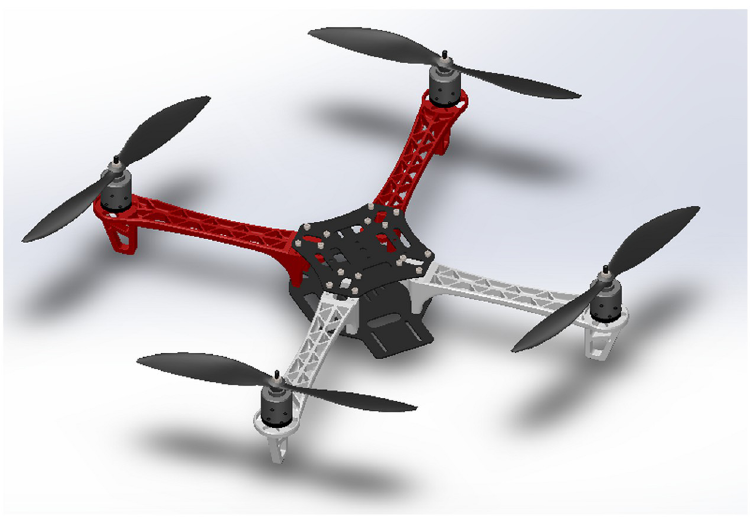
Fig 10. Quadrotor’s 3D CAD model.